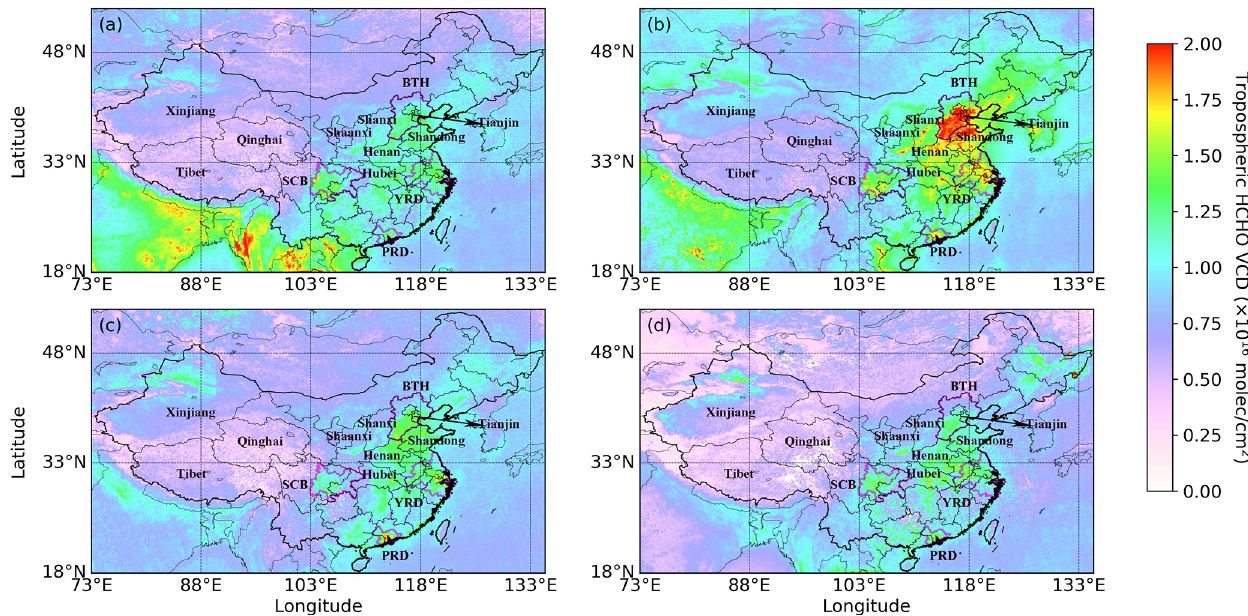
Figure 11. The spatial distribution of average tropospheric HCHO VCDs over China on a 0.1 ◦ × 0.1 ◦ grid in spring (a) , summer (b) , autumn (c) and winter (d) .